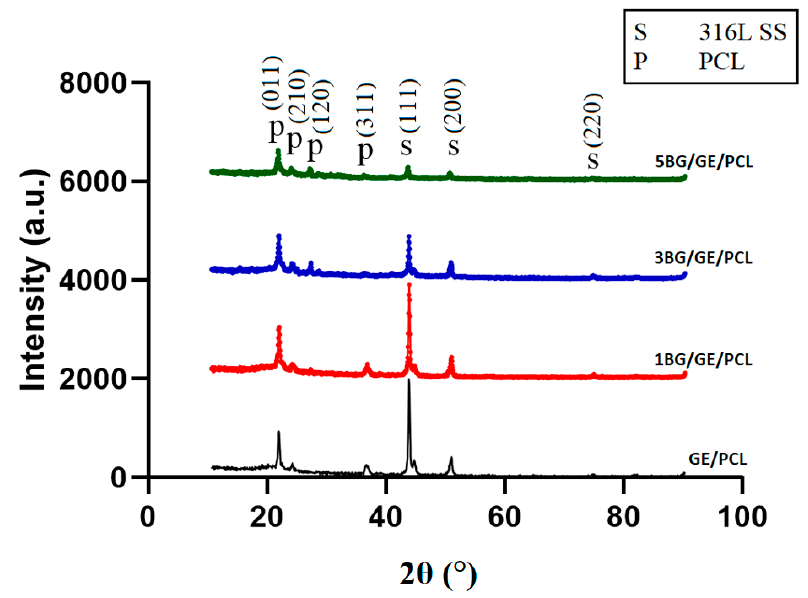
Figure 3. The XRD patterns of GE / PCL and BG / GE / PCL composites.